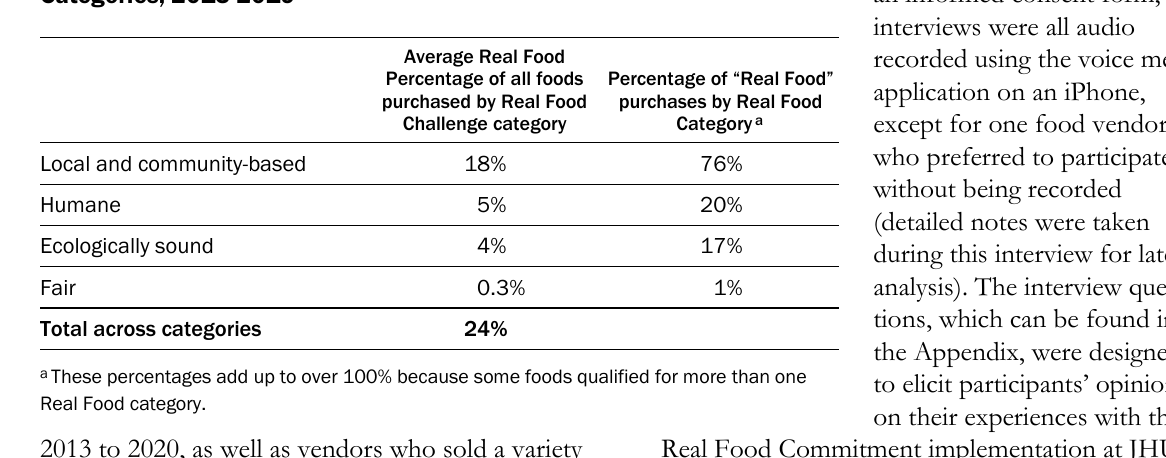
Table 1. Spending on “Real Food” by the Real Food Challenge